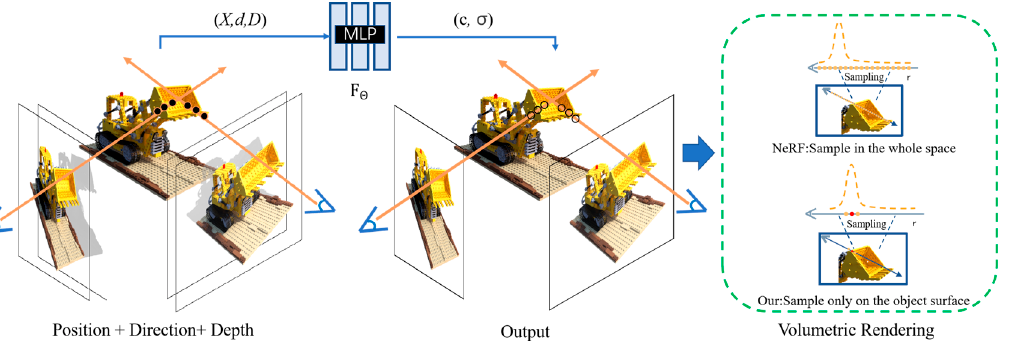
Figure 4. The overall framework of the Depth-DYN NeRF network, including the Depth-DYN MLP on the left and the volumetric rendering on the right.